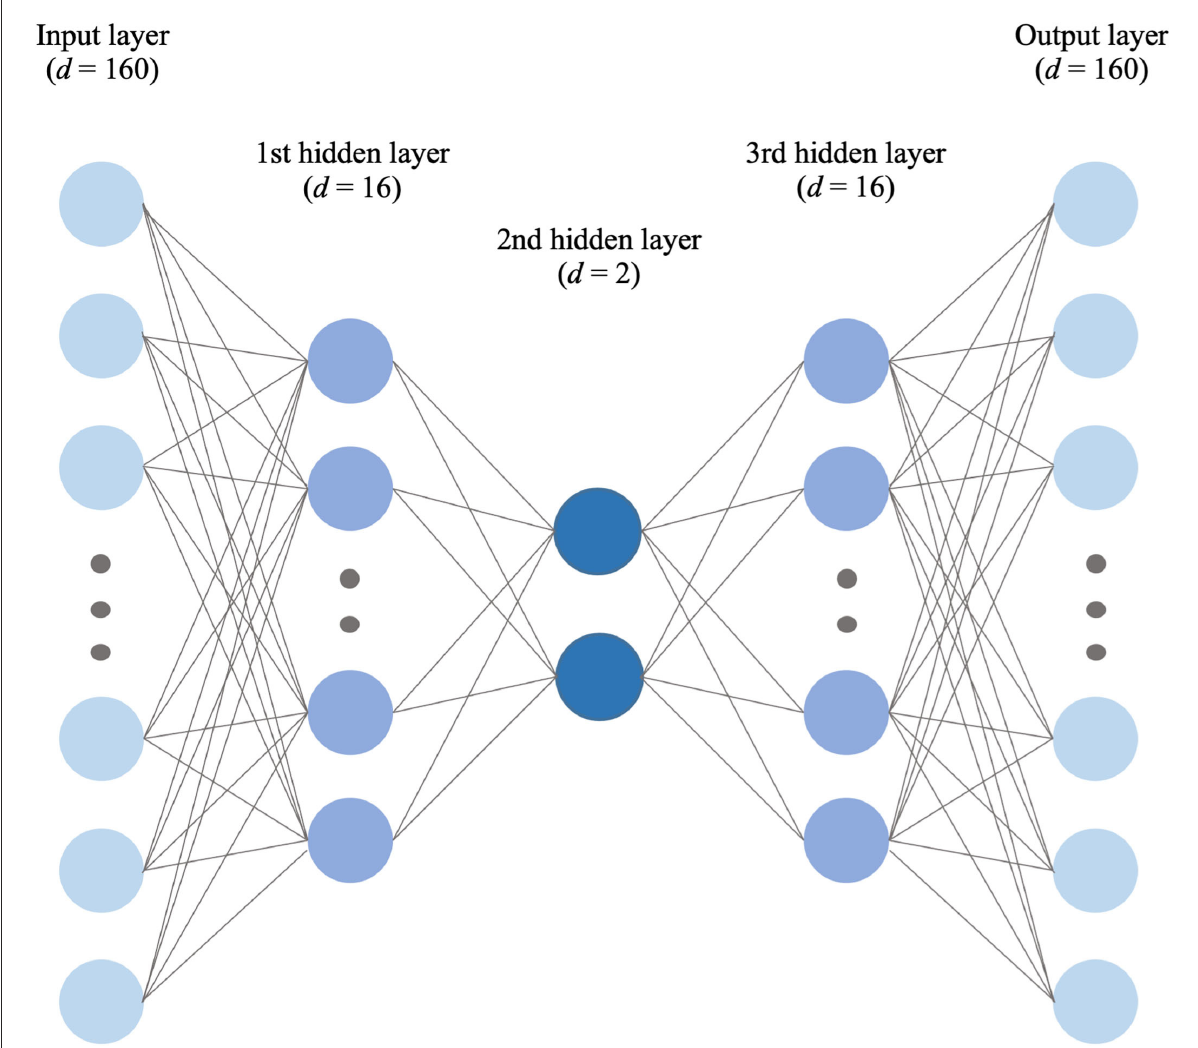
FIGURE5 The final selected deep autoencoder model architecture for feature